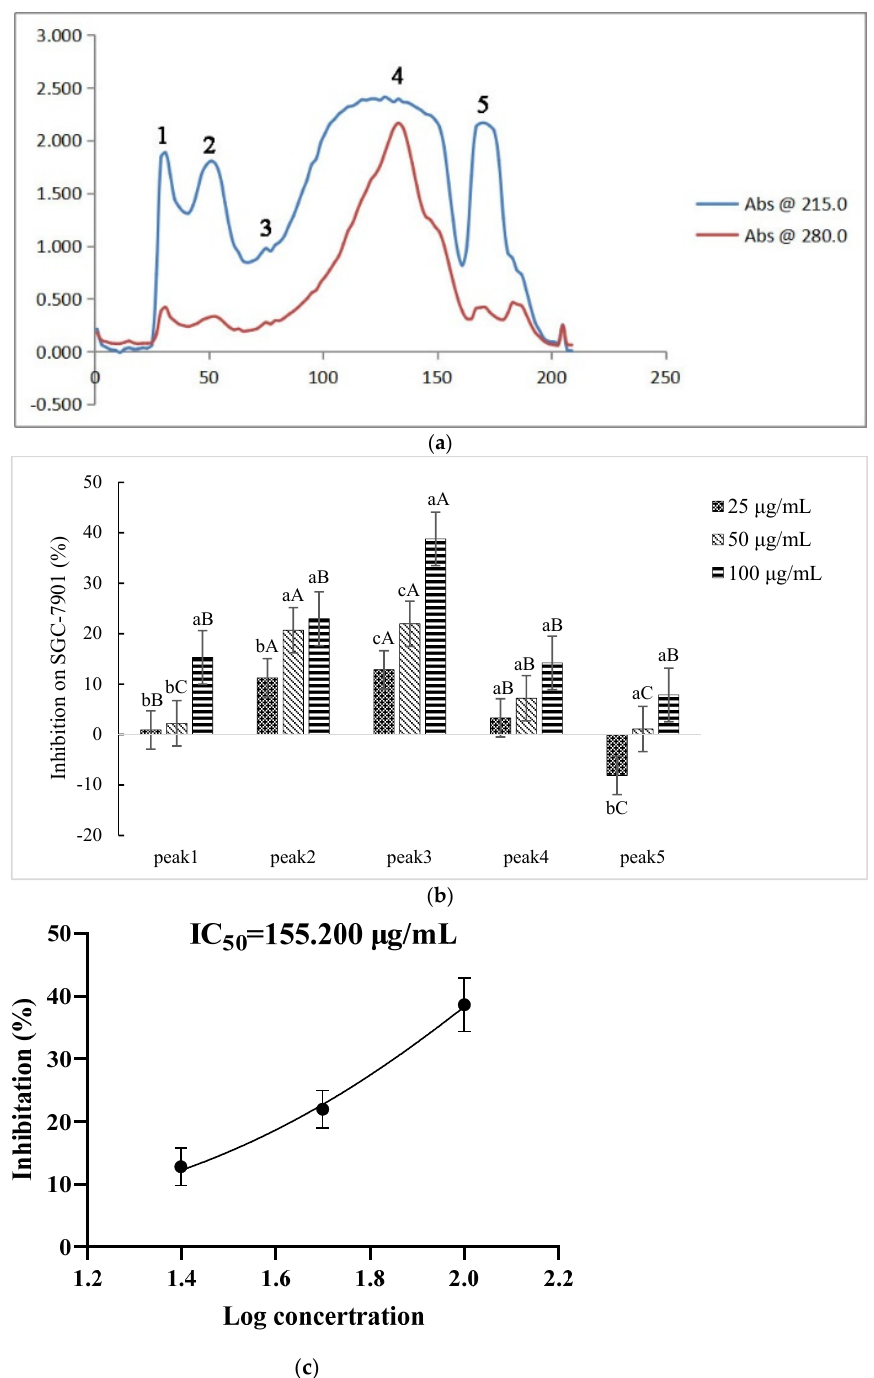
Figure 2. Inhibiting effect of components separated by gel filtration chromatography. ( a ) The elution curve of gel filtration chromatography. ( b ) Inhibitory rates of cell proliferation (SGC-7901 cells) induced by Sect. II-1–5 that were separated by gel filtration chromatography after 48 h treatment. a, b, c means p < 0.05; A, B, C means p < 0.01. ( c ) IC 50 curve fitting of Sect. II-3.